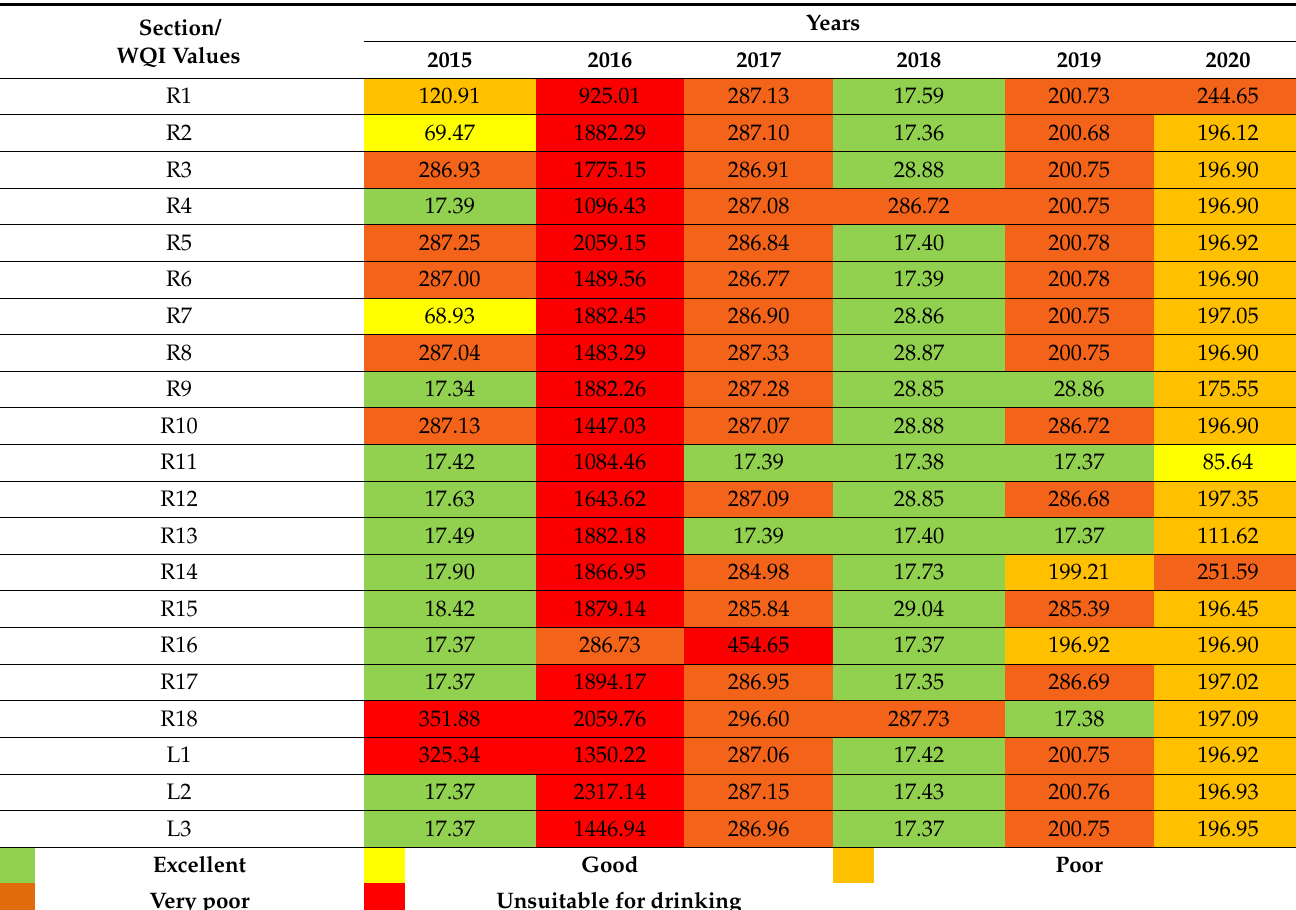
Table 4. The annual WQI average obtained values (HM and